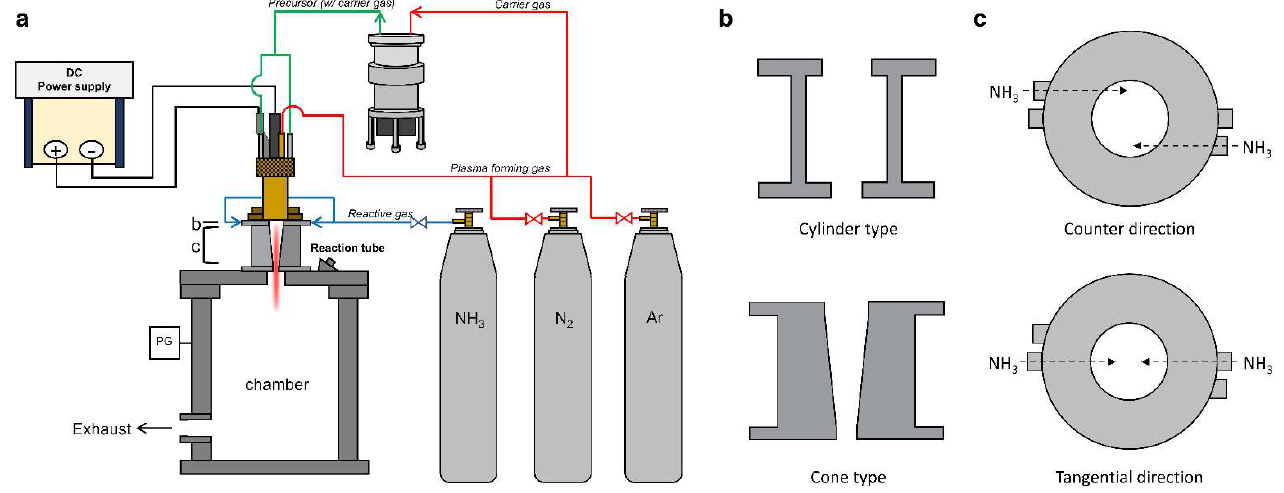
Figure 1. Illustration of experimental apparatus; ( a ) schematic diagram of the thermal plasma sys- tem, ( b ) geometry of the reaction tube (cylinder- and cone-type tubes), and ( c ) dimensions of injec- tion nozzle for ammonia gas (counter and tangential directions). Table 1. Experimental conditions for synthesizing Si 3 N 4 nanoparticles using thermal plasma.